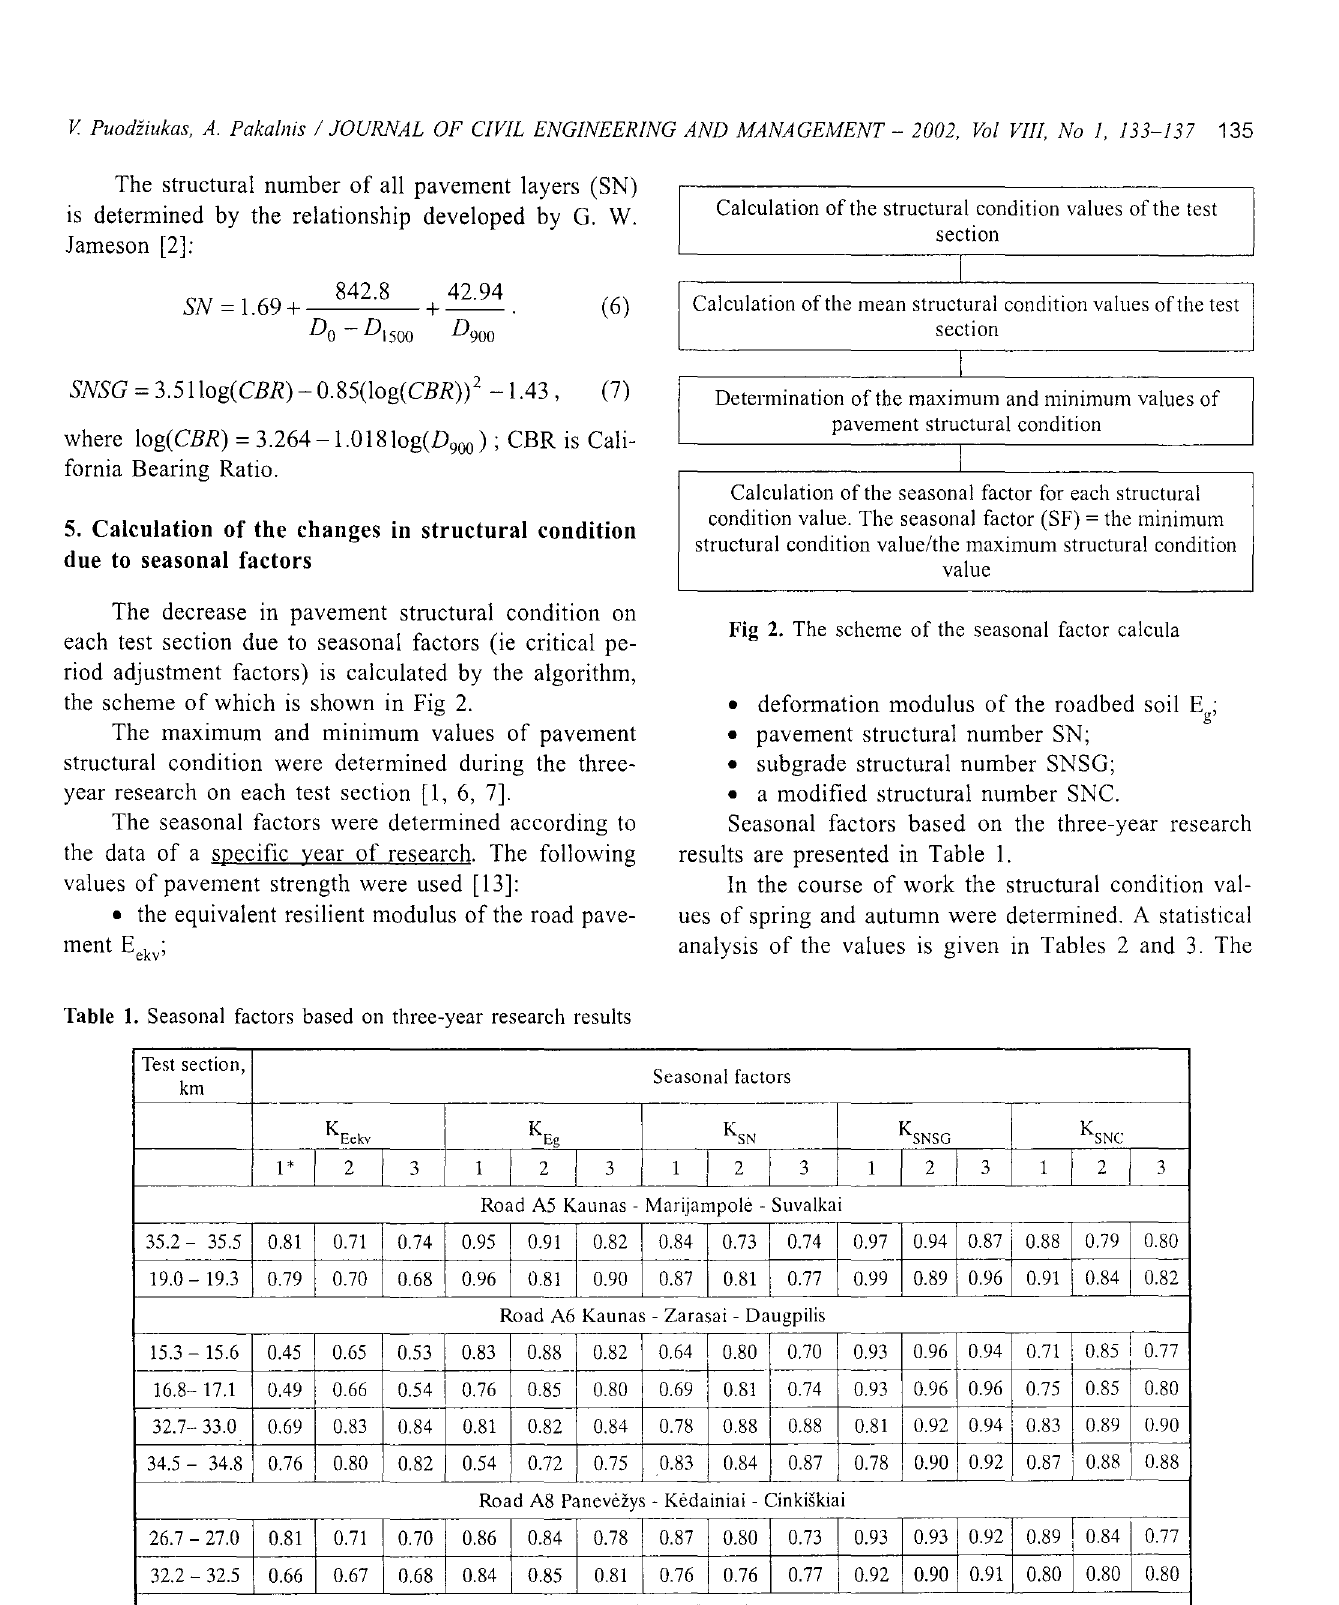
Table 1. Seasonal factors based on three-year research results Test section, km